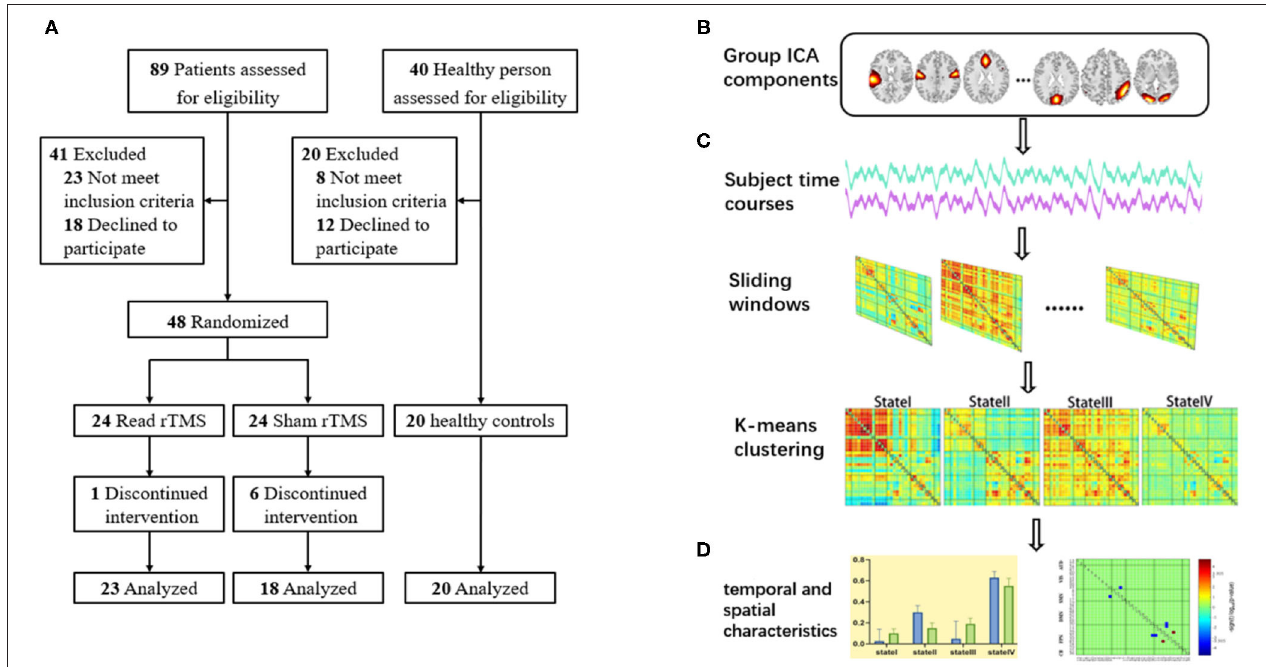
FIGURE 1 | The schematic diagram of the research design. (A) Screening of participants; (B) Group independent component analysis; (C) sliding window approach and clustering analysis; (D) Calculate the temporal indicators and spatial characteristics of FC